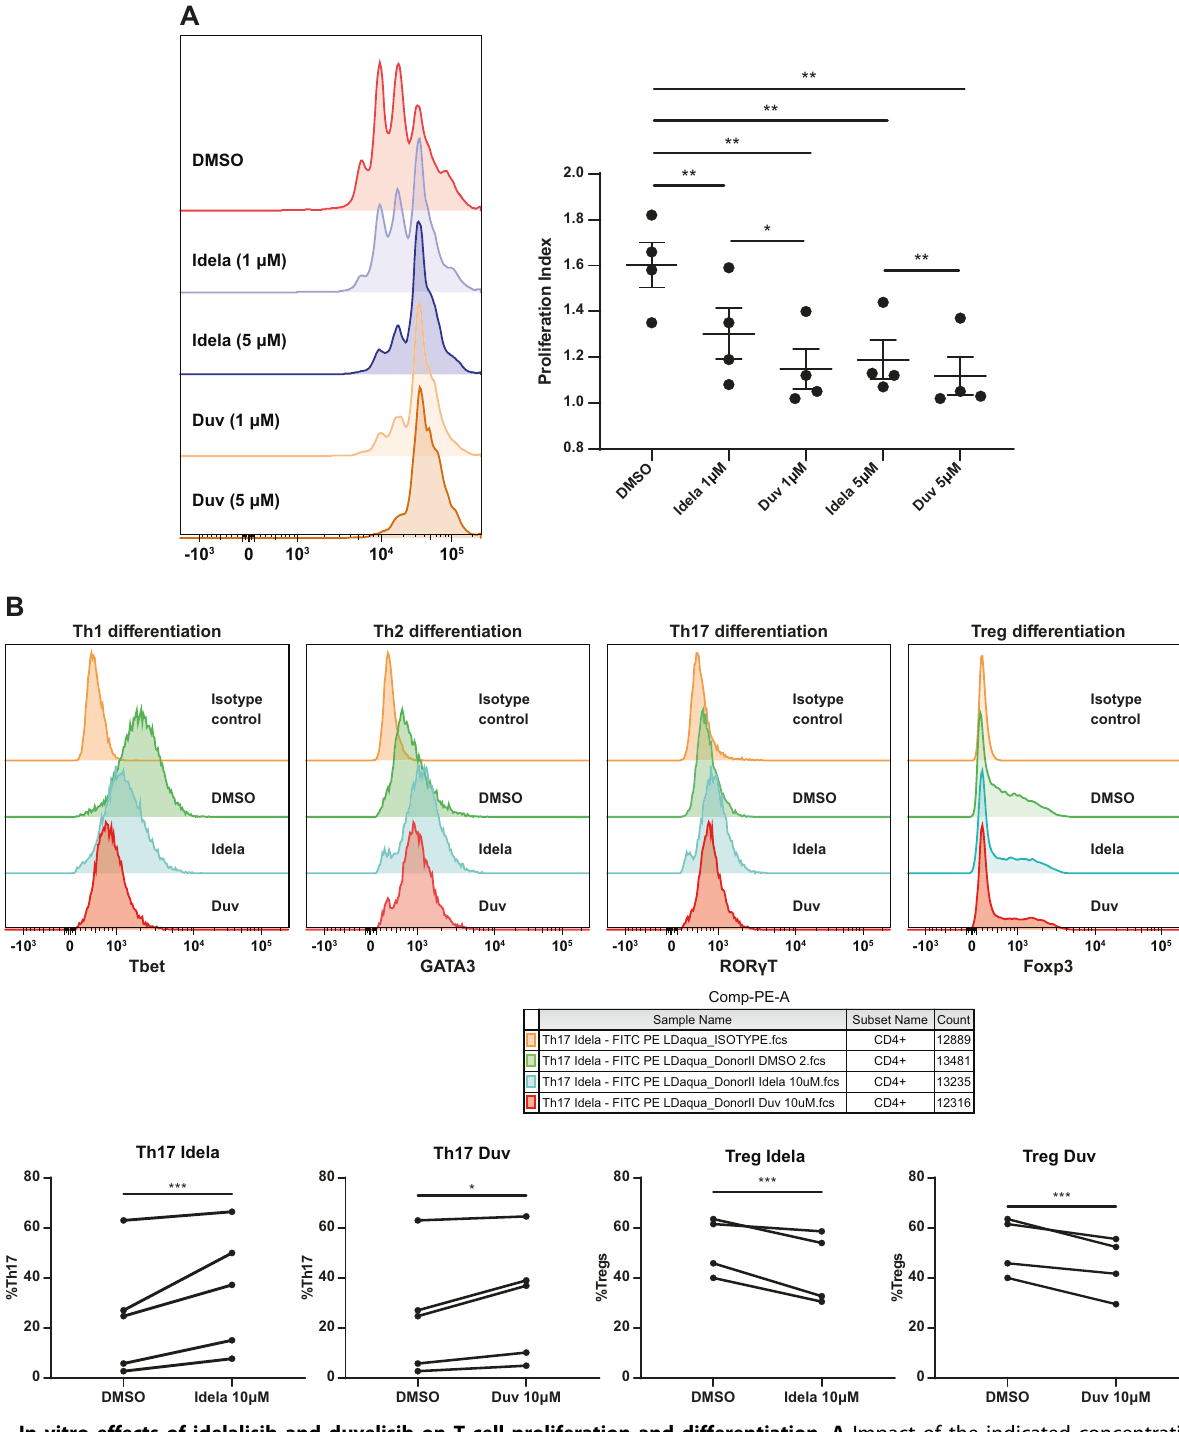
Fig. 1 In vitro effects of idelalisib and duvelisib on T cell proliferation and differentiation. A Impact of the indicated concentrations of idelalisib (Idela) and duvelisib (Duv) on CD3 T cell proliferation as measured by Cell Trace Violet dye. Proliferation index was quanti fi ed using Mod fi t. B In vitro effects of idelalisib and duvelisib at 10 μ M on differentiation of naive CD4 + T cells to Th1 (T-bet), Th2 (GATA-3), Th17 (ROR γ T), and Treg (FOXP3) phenotypes. * p ≤ 0.05; ** p ≤ 0.01; *** p ≤